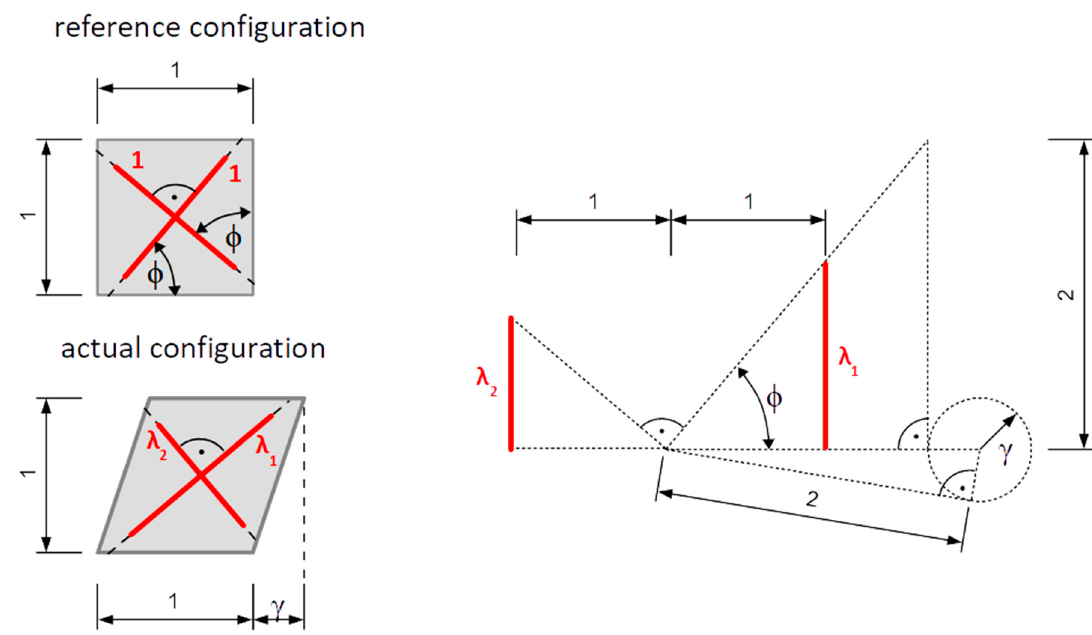
Figure 1. Geometrical interpretation of parameters describing the simple shear state.